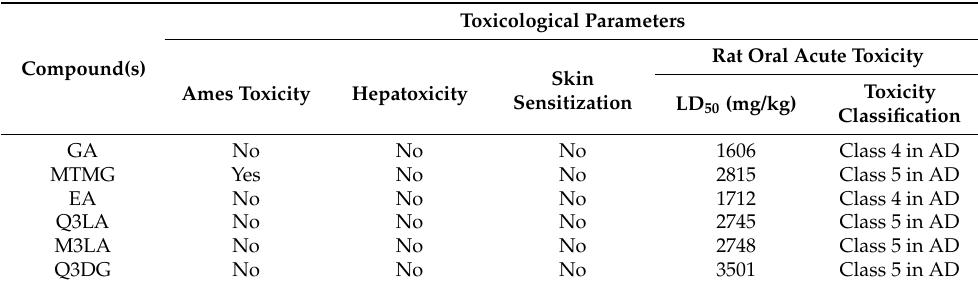
Table 7. Toxicological profiles of the selected compounds from W. fruticosa